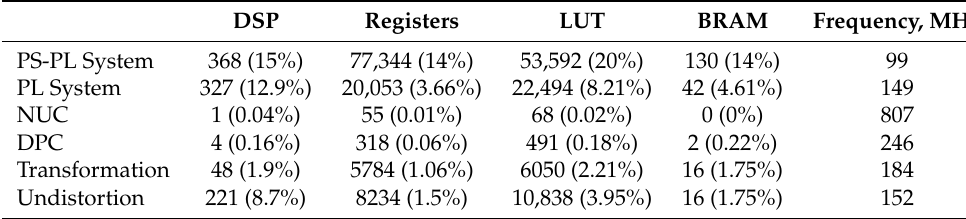
Table 1. Resource utilization for the developed hardware system’s